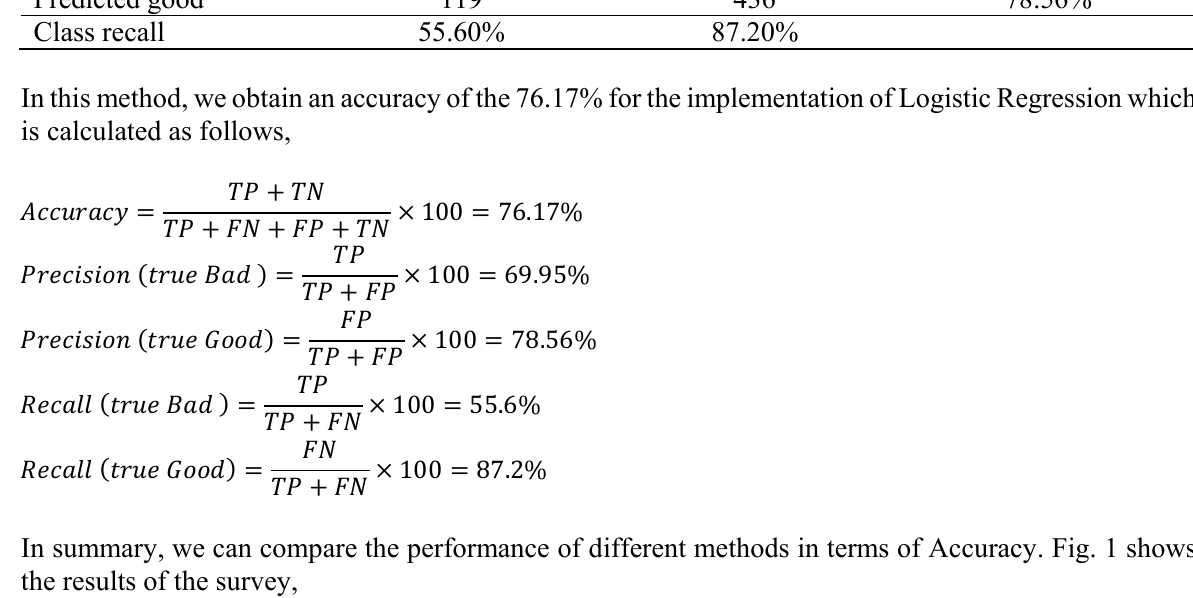
Table 9 The results of the implementation of Logistic Regression Truly bad Truly good Class precision Predicted bad 149 64 69.95% Predicted good 119 436 78.56% Class recall 55.60%